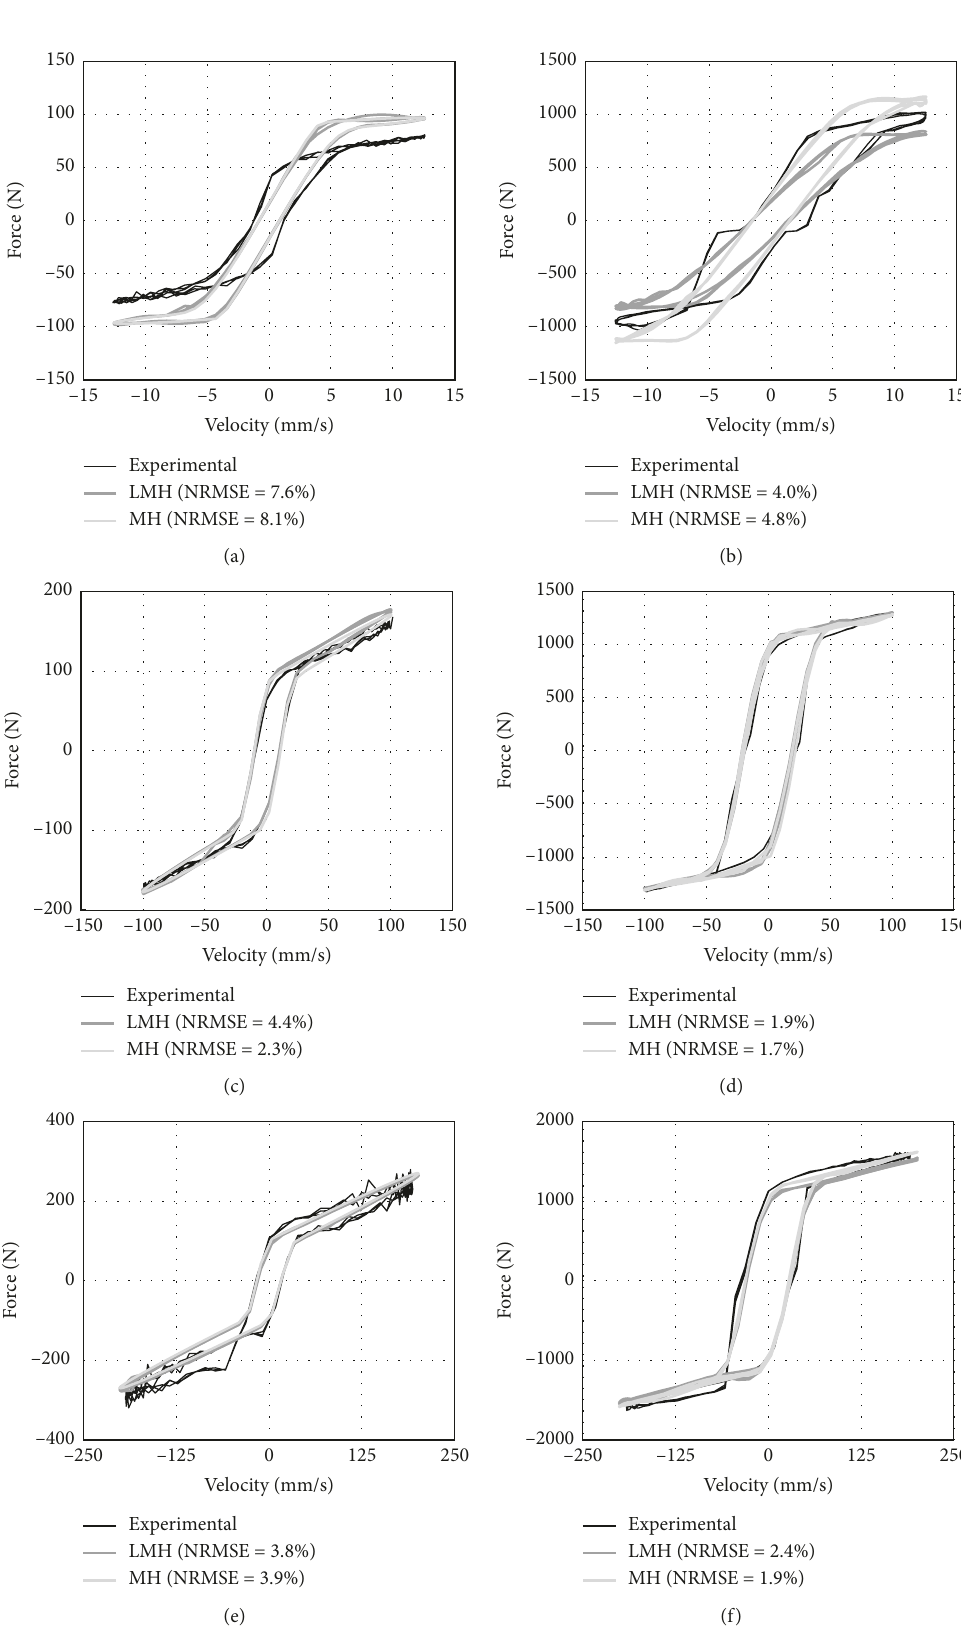
Figure 15: Spencer model (fitted with LMH and MH tests) predictions for six different tests: (a) low velocity without intensity; (b) low velocity with I � 1 A; (c) medium velocity without intensity; (d) medium velocity with I � 1A; (e) high velocity without intensity; (f) high velocity with I �